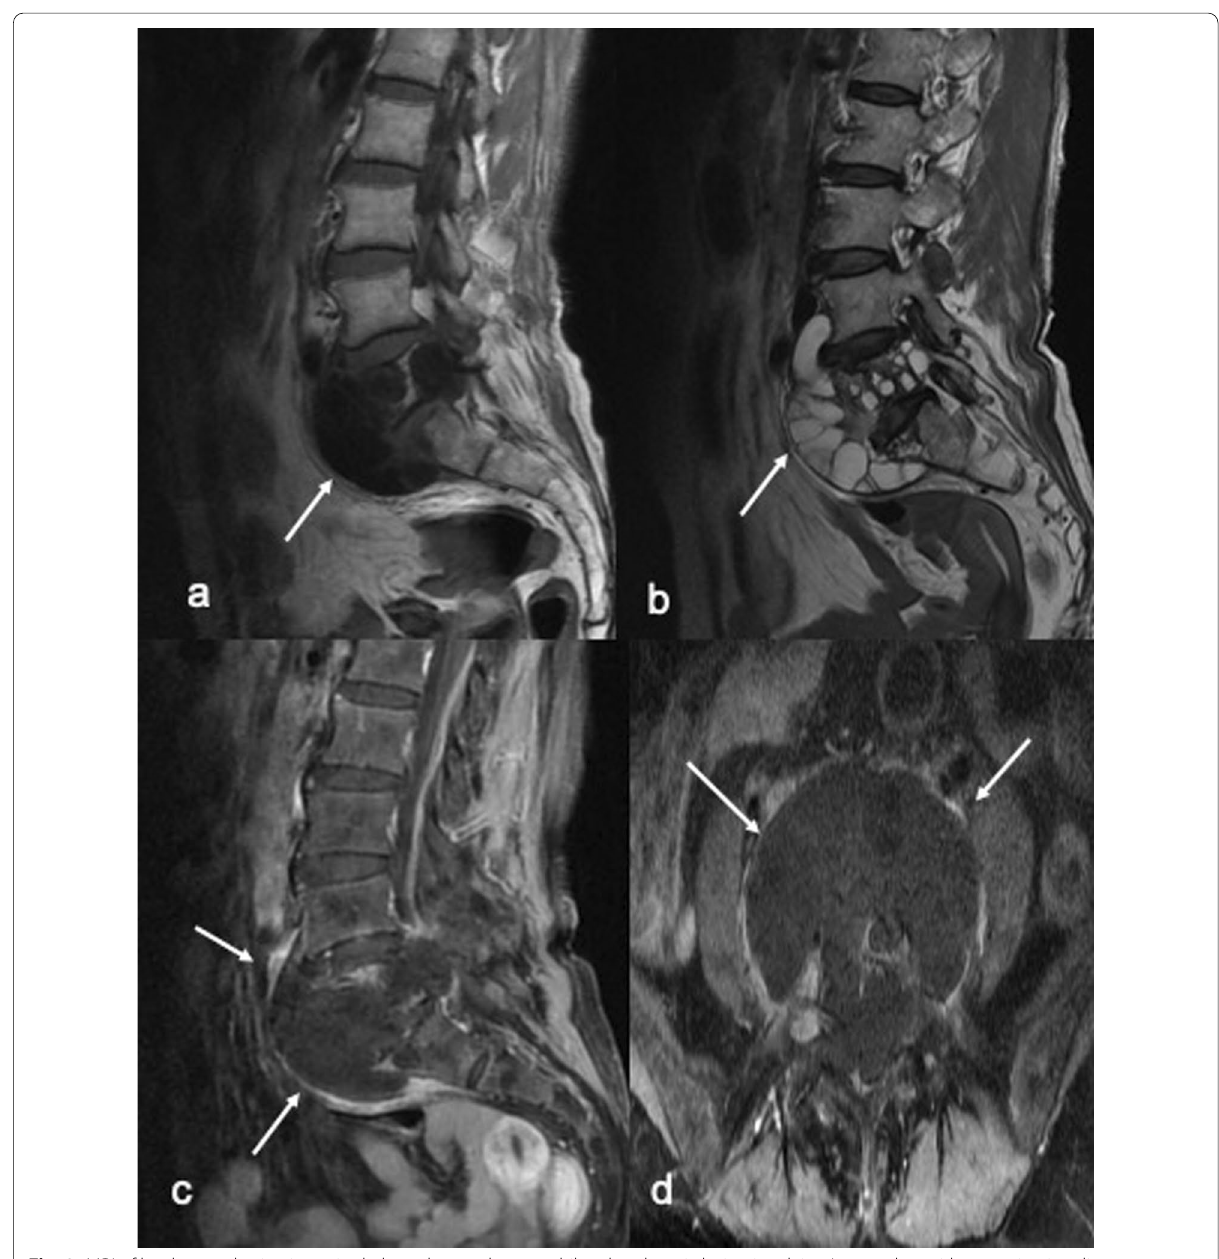
Fig. 3 MRI of lumbosacral spine in sagittal plane shows a large multiloculated cystic lesion involving L5 vertebra with extension in adjacent prevertebral soft tissue and spinal canal. The lesion is a hypointense on T1WI and b hyperintense on T2WI. c Fat-suppressed contrast-enhanced sagittal and d axial T1WI shows rim enhancement of adjacent compressed tissue (marked with white